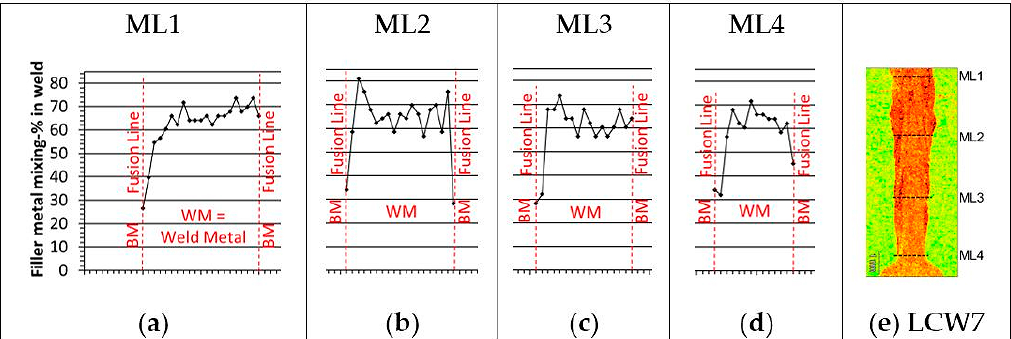
Figure 19. Filler metal mixing results from EDS stepwise characterization. ( a – d ) Filler metal mixing-% profiles of measurement lines 1–4 (ML1–ML4) from test weld LCW7 ( e ). In figures ( a – d ) one step between adjacent measurement points in the horizontal axis equals 100 micrometres.